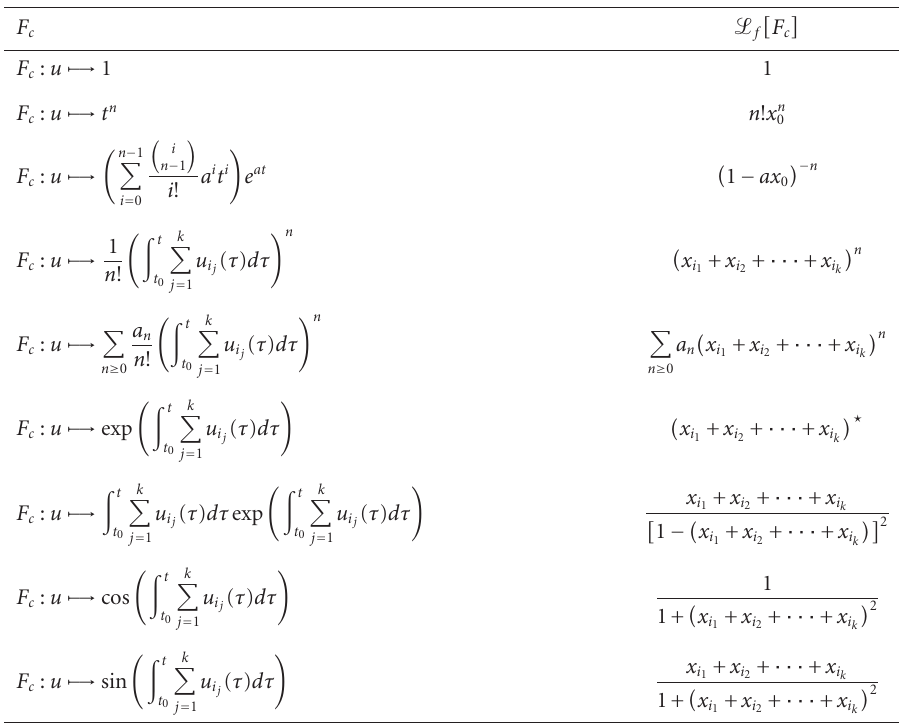
Table 2.1. Some formal Laplace-Borel transform